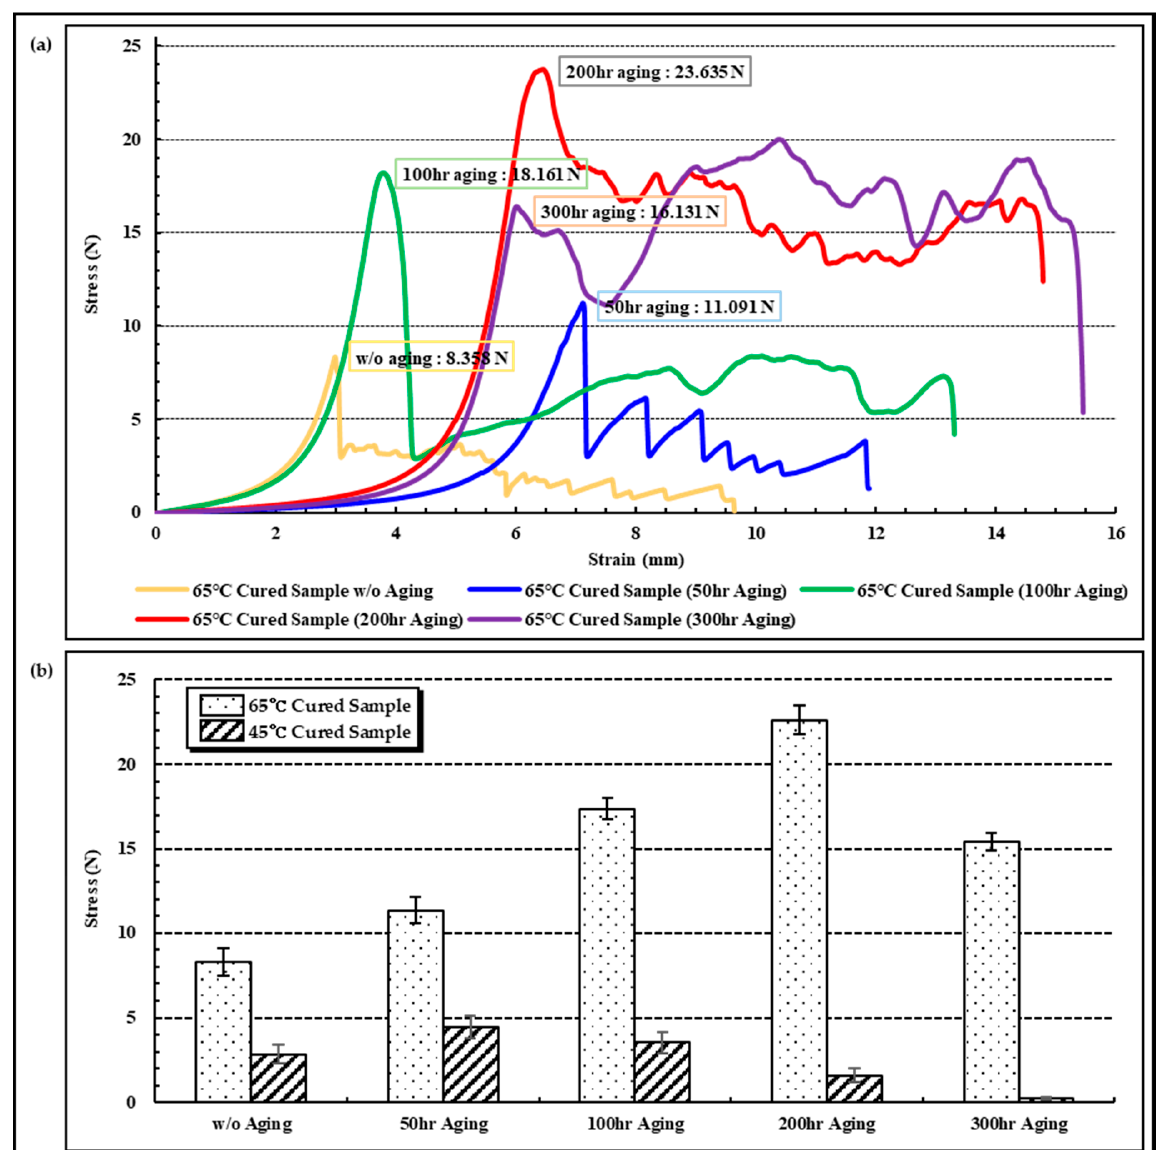
Figure 7. Results of acceleration aging test in 65°C PBS solution at 50, 100, 200, 300 h. ( a ) Results of tear test of 65°C cured sample after each aging time and ( b ) maximum tear force comparison between 45°C and 65°C cured samples.